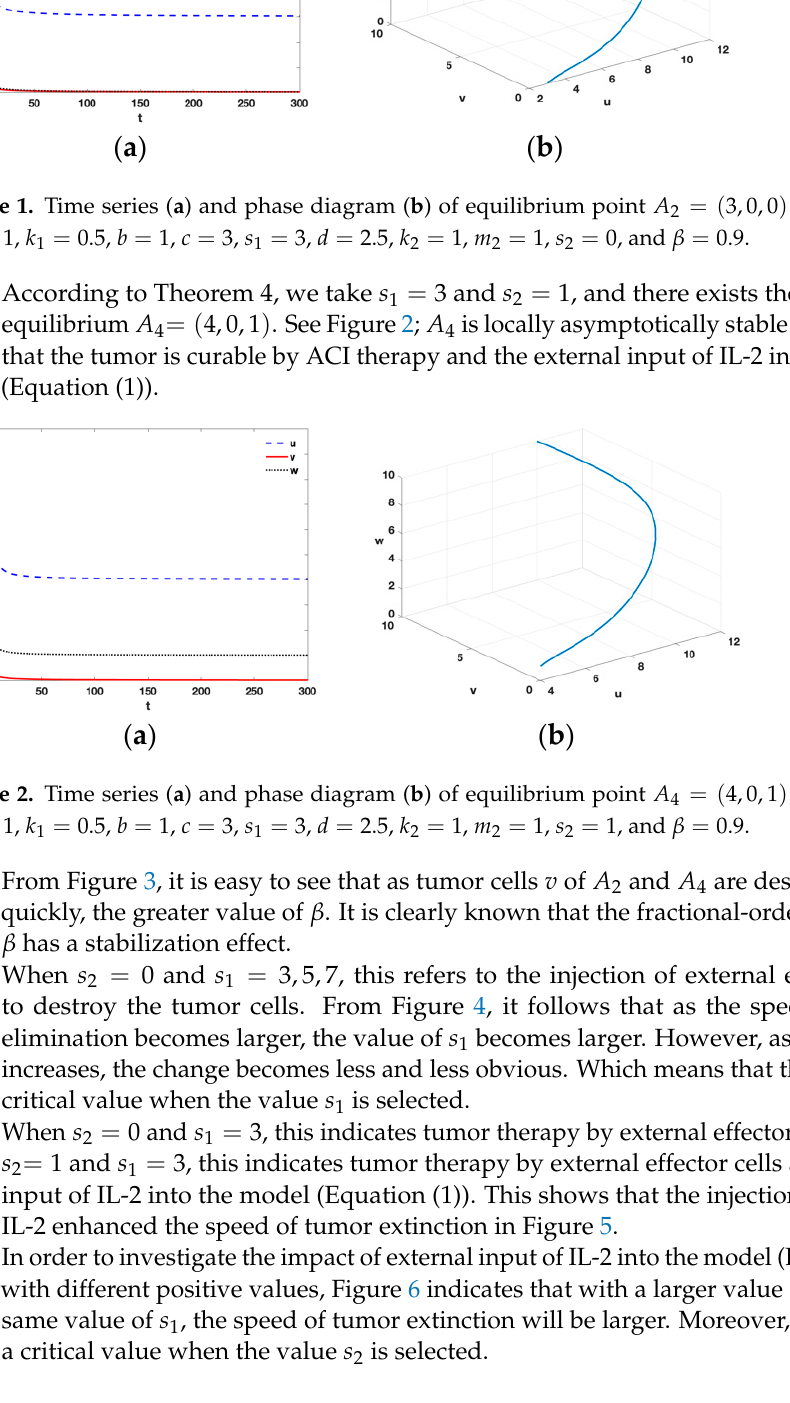
Figure 3. Time series of model (Equation (1)) with